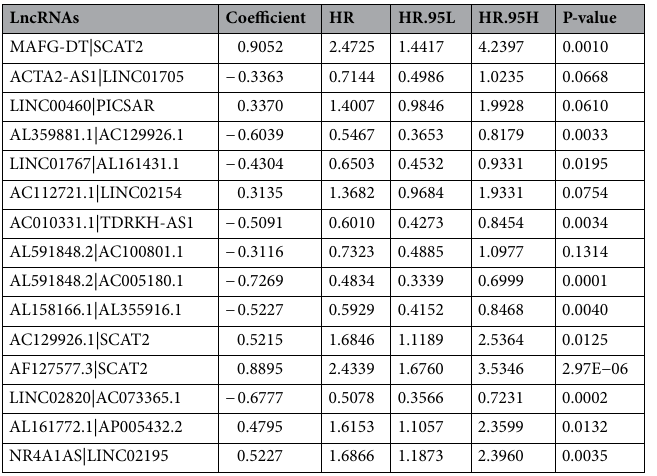
Table 1. Regression coefficients of each factor in this prognostic immune-related lncRNA signature. HR hazard ratio, HR.95L 95% CI lower limit, HR.95H 95% CI upper